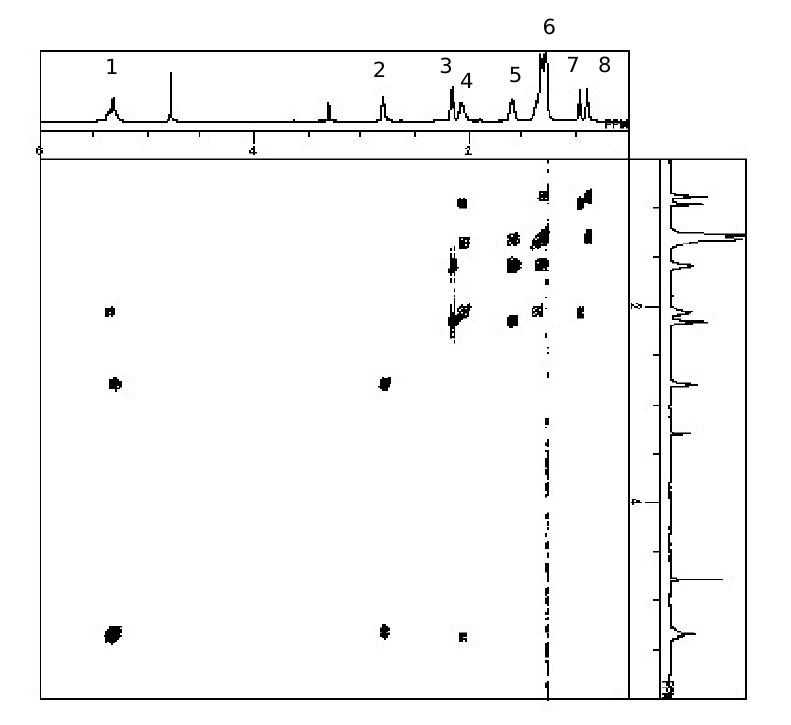
Figure 1 . 1 H- 1 H COSY spectrum of 2-acyloxyethylphosphonate isolated from cyanobacterial waterbloom material. CD 1 2 3